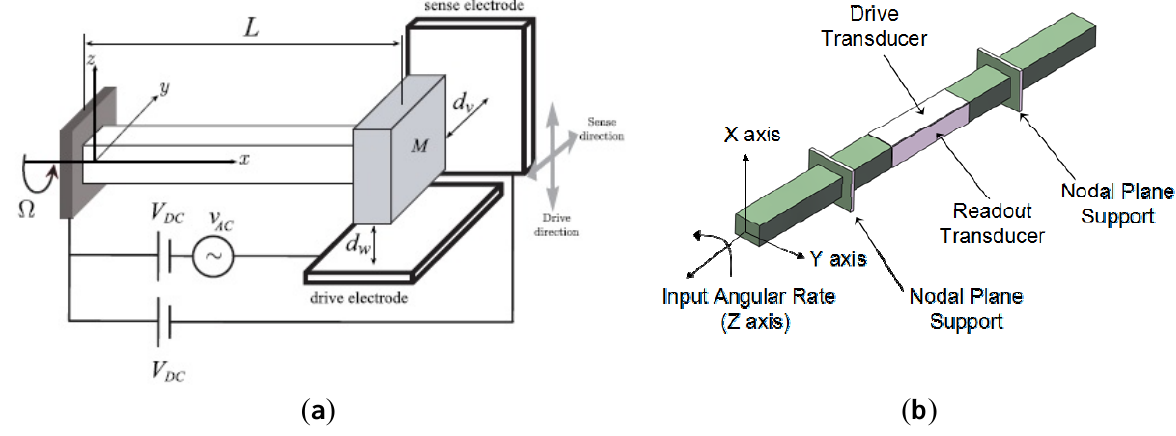
Figure 24. Vibrating beam gyroscopes. ( a ) Clemson University gyroscope. (b ) Chongqing University of Posts and Telecommunications gyroscope.